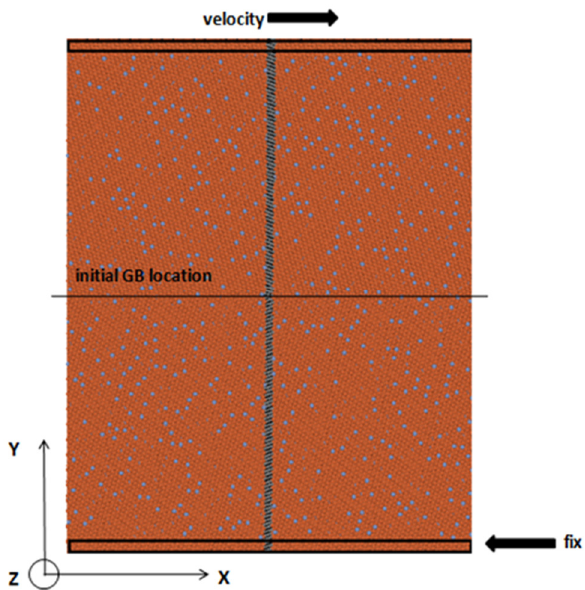
Figure 1. The structure of the Σ9[110](221) GB in the Fe-5 at.% Cr alloy. Red spots represent Fe atoms and light gray spots represent Cr atoms. Dark gray atoms initially perpendicular to the GB interface are selected for marking SCGBM.